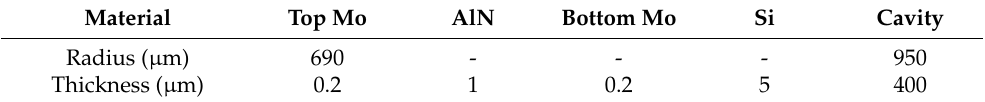
Table 1. Geometric parameters of the